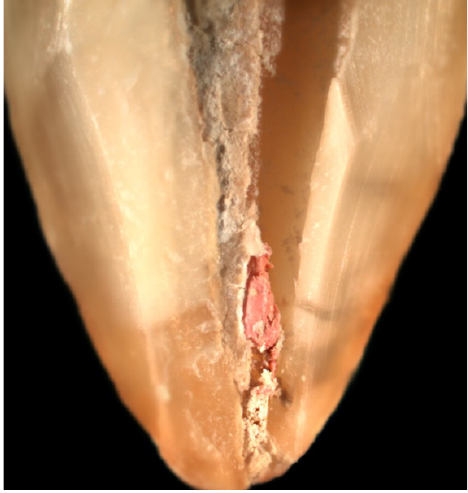
Figure 2. Image obtained in a stereomicroscope (16 × ) after root canal retreatment in a lower incisor. The system used was the Universal ProTaper (final instrument F4).